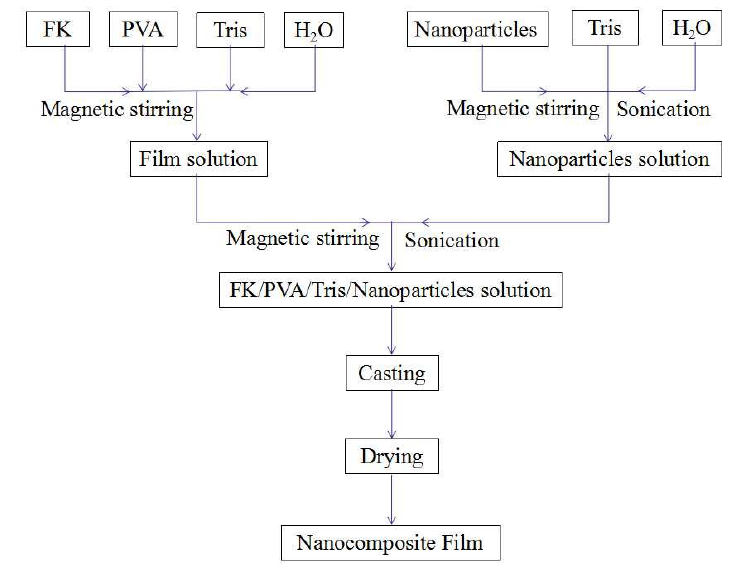
Figure 1. Different steps in the film forming process.